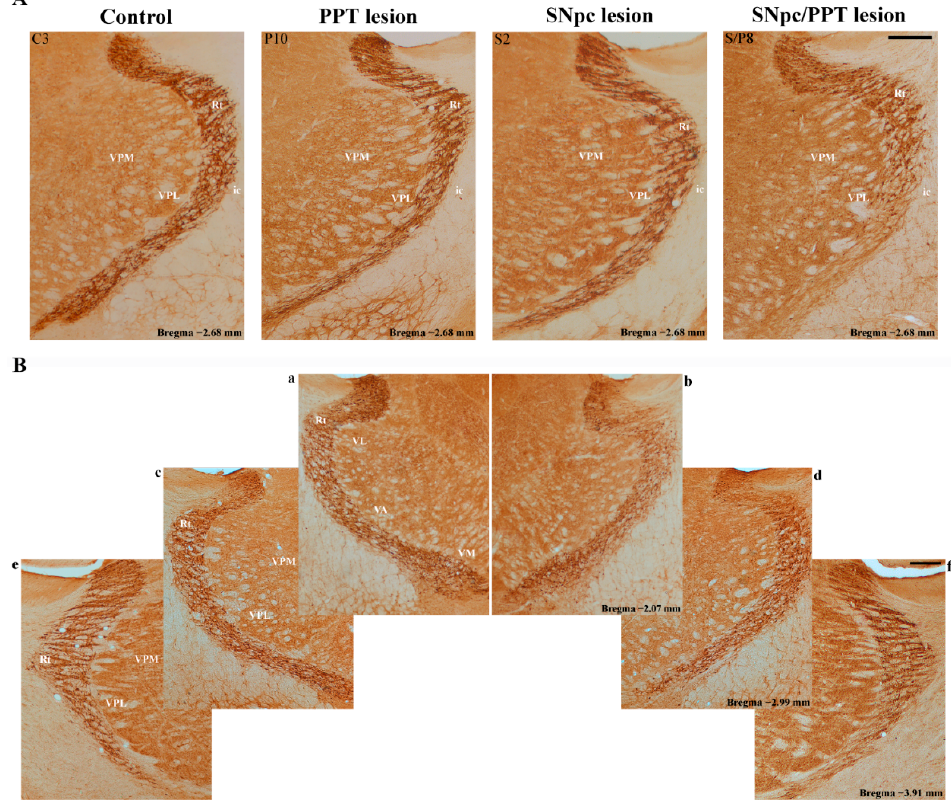
Figure 11. Individual examples of PV immunostaining alteration within RT in the distinct rat models of PD neuropathology. ( A ) The typical individual examples of PV immunoreactivity within RT in the control rat (Control, C3), rat with PD cholinopathy (PPT lesion, P10), hemiparkinsonian rat (SNpc lesion, S2), and hemiparkinsonian rat with PD cholinopathy (SNpc/PPT lesion, S/P8; see also Figure S3); ( B ) The antero-posterior dimension of PV immunoreactivity defect in the hemiparkinso- nian rat with PD cholinopathy (SNpc/PPT lesion, S/P8) spreads from − 2.07 to − 3.91 mm posterior from bregma, ipsilaterally to the combined lesion ( b , d , f ), and vs. the contralateral brain side ( a , c , e